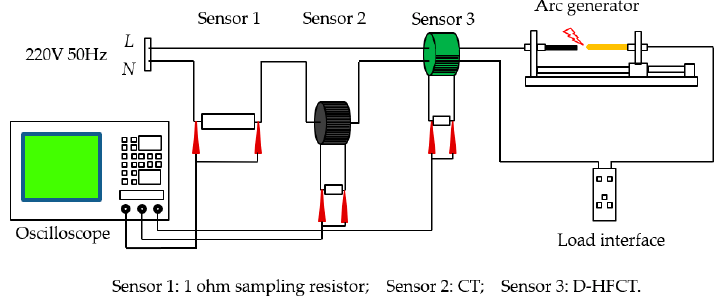
Figure 17. Schematic diagram of the series arc fault experimental simulation system.